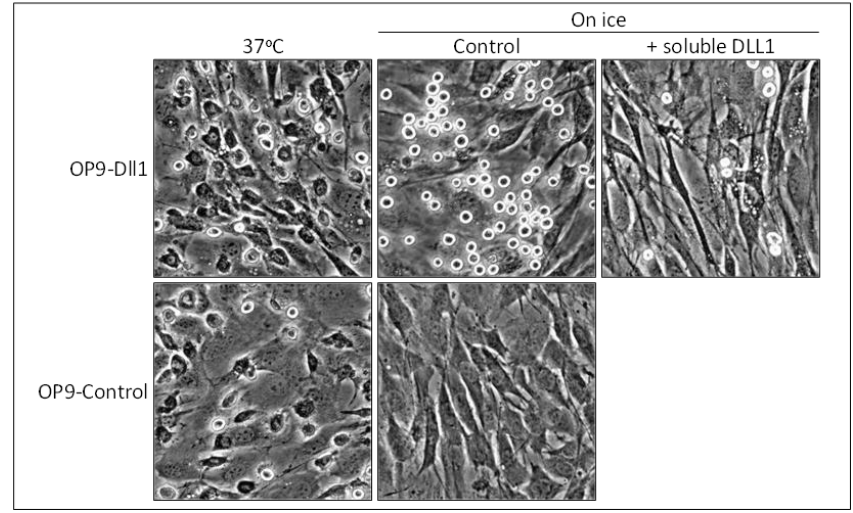
Figure 3. Mammalian Notch family members function as adhesion molecules. Representative photomicrographs of adherent mast cells after the removal of non-adherent cells are shown. Many adherent mast cells spread on stromal cells with a deformed morphology at 37 °C, while those on OP9-Dll1 cultured on ice tethered, maintaining their original morphology. Photomicrographs are from reference [14] ( Copyright 2010. The American Association of Immunologists, Inc. , Bethesda, MD, USA).